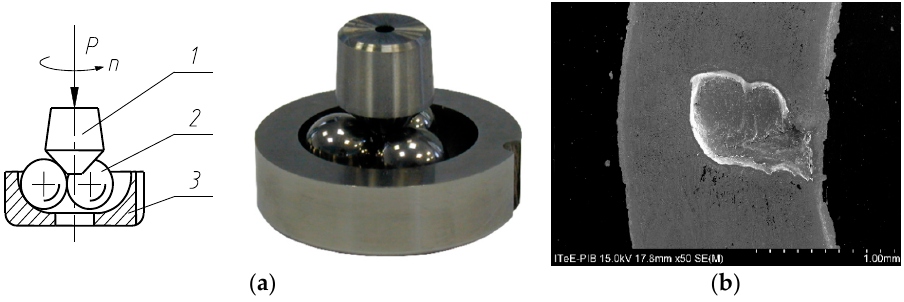
Figure 2. ( a ) Cone ‐ balls tribosystem:1—cone, 2—balls, 3—race; ( b ) SEM image of a typical pit on the cone.